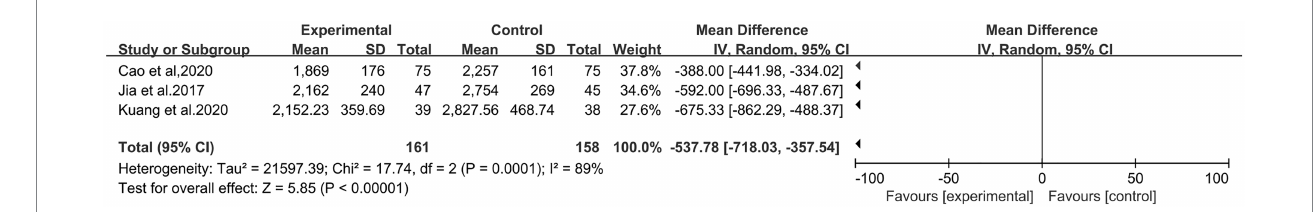
FIGURE 6 Meta-analysis for comparison of NT-proBNP between the experimental and control